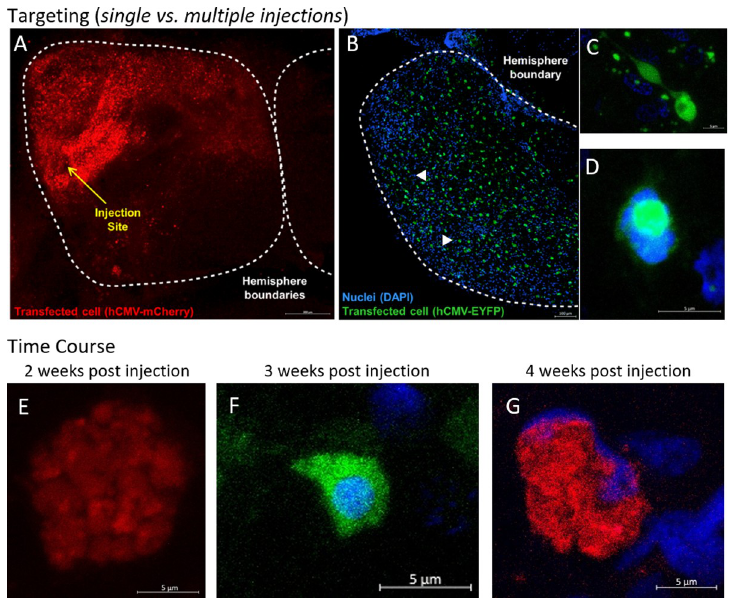
Fig 3. Fluorescent expression resulting from viral-mediated transgenesis. More refined targeting of brain regions is possible by limiting the number of injections. A) Single injection resulting in local expression, limited to a portion of one hemisphere of the anterior telencephalon. B) Broad expression throughout the entire left hemisphere of the diencephalon, typical for injections with delivery at multiple depths. No fluorescence was seen in any saline injected controls. C & D) Successful transfection of cells by the long term hCMV-EYFP construct in the lateral left diencephalon shown in B at three weeks after injection. E-G) Fluorescent expression profile over time for the hCMV promoter. No fluorescence was seen during the 10 days following injection. Weak but increasingly strong signal was seen between 10–12 days (not shown) following injections regardless of the fluorescent protein, mCherry (E & G) or EYFP (F). Peak expression was observed beginning around day 13 or 14 post injection. There was no qualitative difference in fluorescent intensity between two to four weeks, the maximum examined time point, following injection. Behavior was assessed at 14- and 16-days post